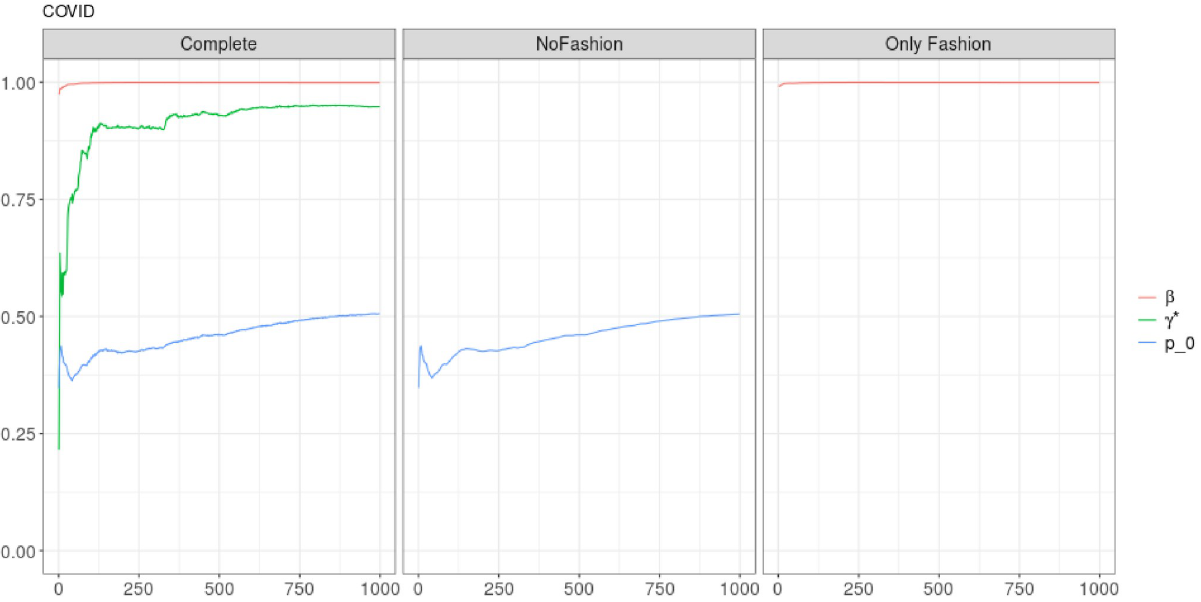
Fig 11. “Covid” ( T = 0.35, entire, D = 3 0 ): Model parameters evolution with S = 1000 slots of equal size (i.e. 2037 observations). All parameters are nearly constant or slowly converging.